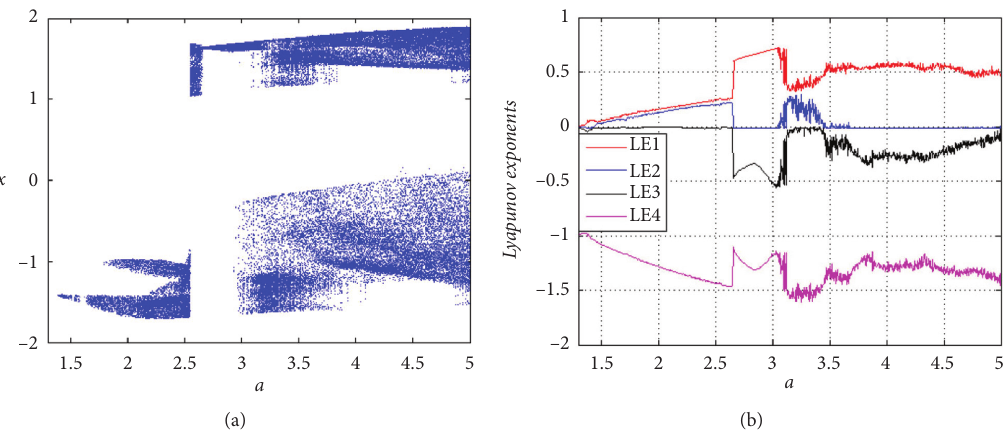
Figure 2: Dynamic behavior with increasing the parameter a in the interval of [1.3, 5]. (a) Bifurcation diagrams of x . (b) Lyapunov exponent spectrum.